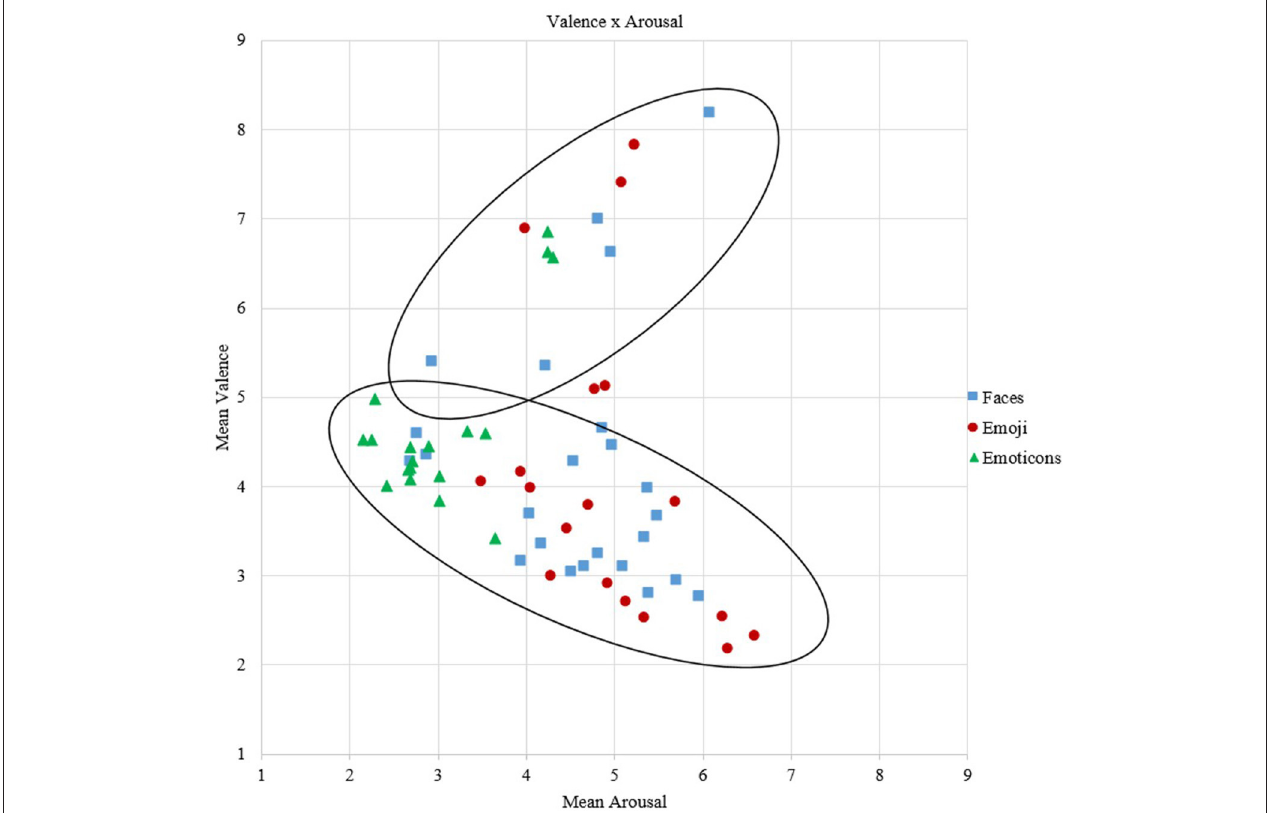
FIGURE 5 | Mean corresponding valence and arousal scores for each stimulus according to the category.